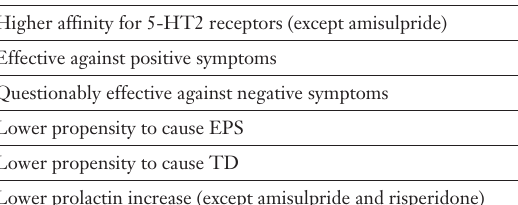
Pharmacological and clinical features of atypical antipsy-